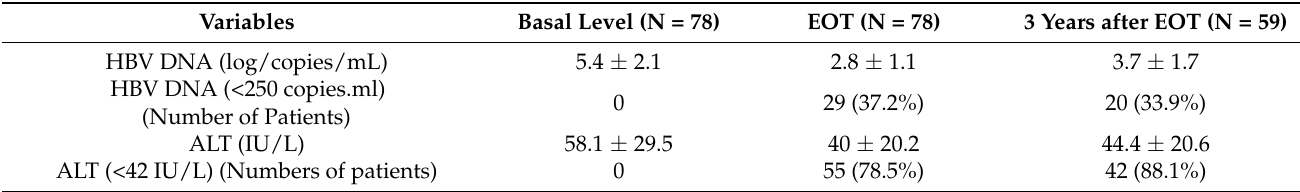
Table 3. Viral and biochemical data of the patients at three